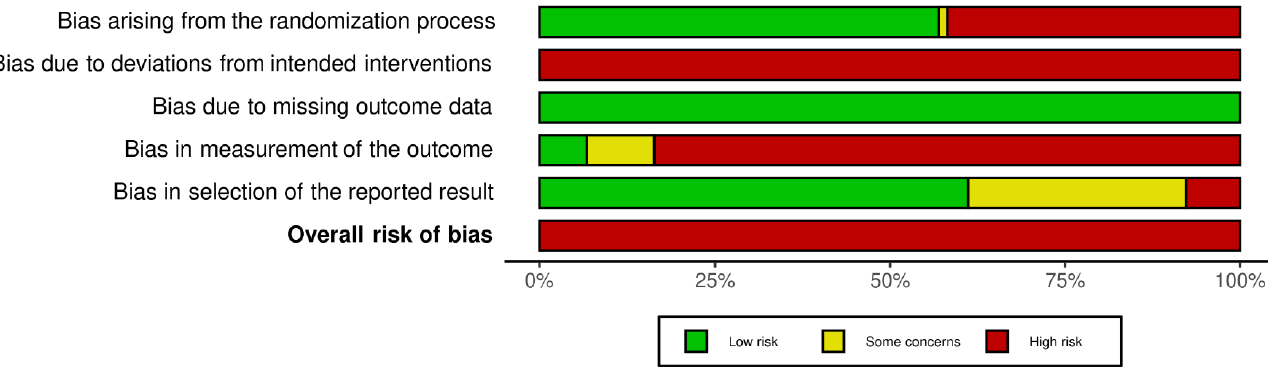
Figure 1. Risk of bias graph according to the Risk of Bias 2 tool.